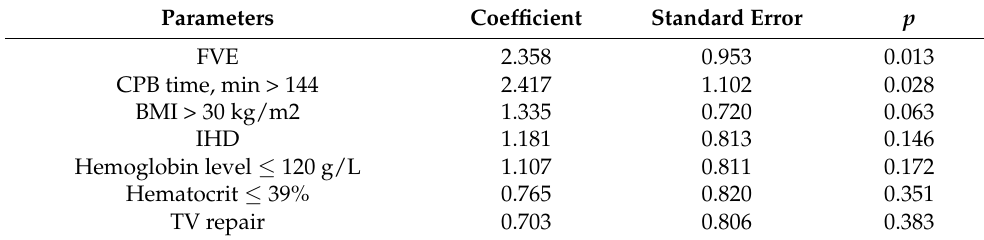
Table 6. Multivariate logistic regression